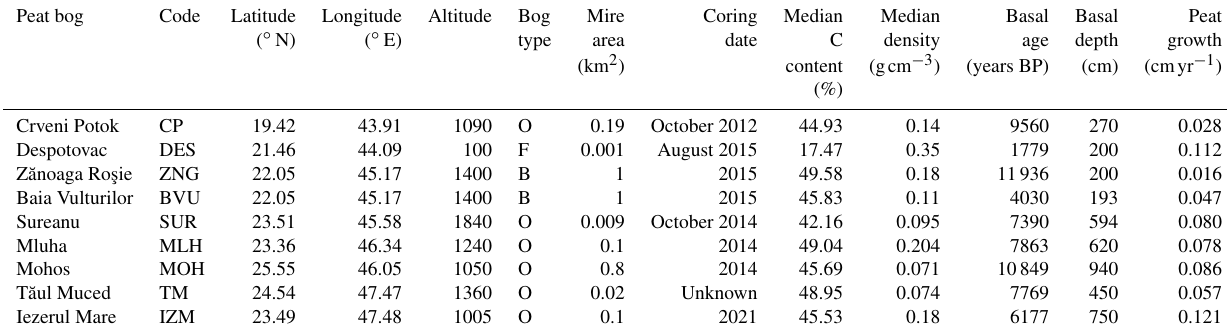
Table 1. The main results of this study. Listed here are the details of each bog involved in this work, including their location, type (O – ombrotrophic, B – blanket, or F – fen), size, depth, and age. In addition, where known, a coring date is indicated. Also presented are the average carbon content, bulk density, and peat